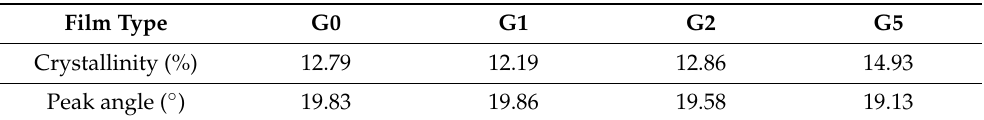
Table 2. Quantitative statistics of creeping